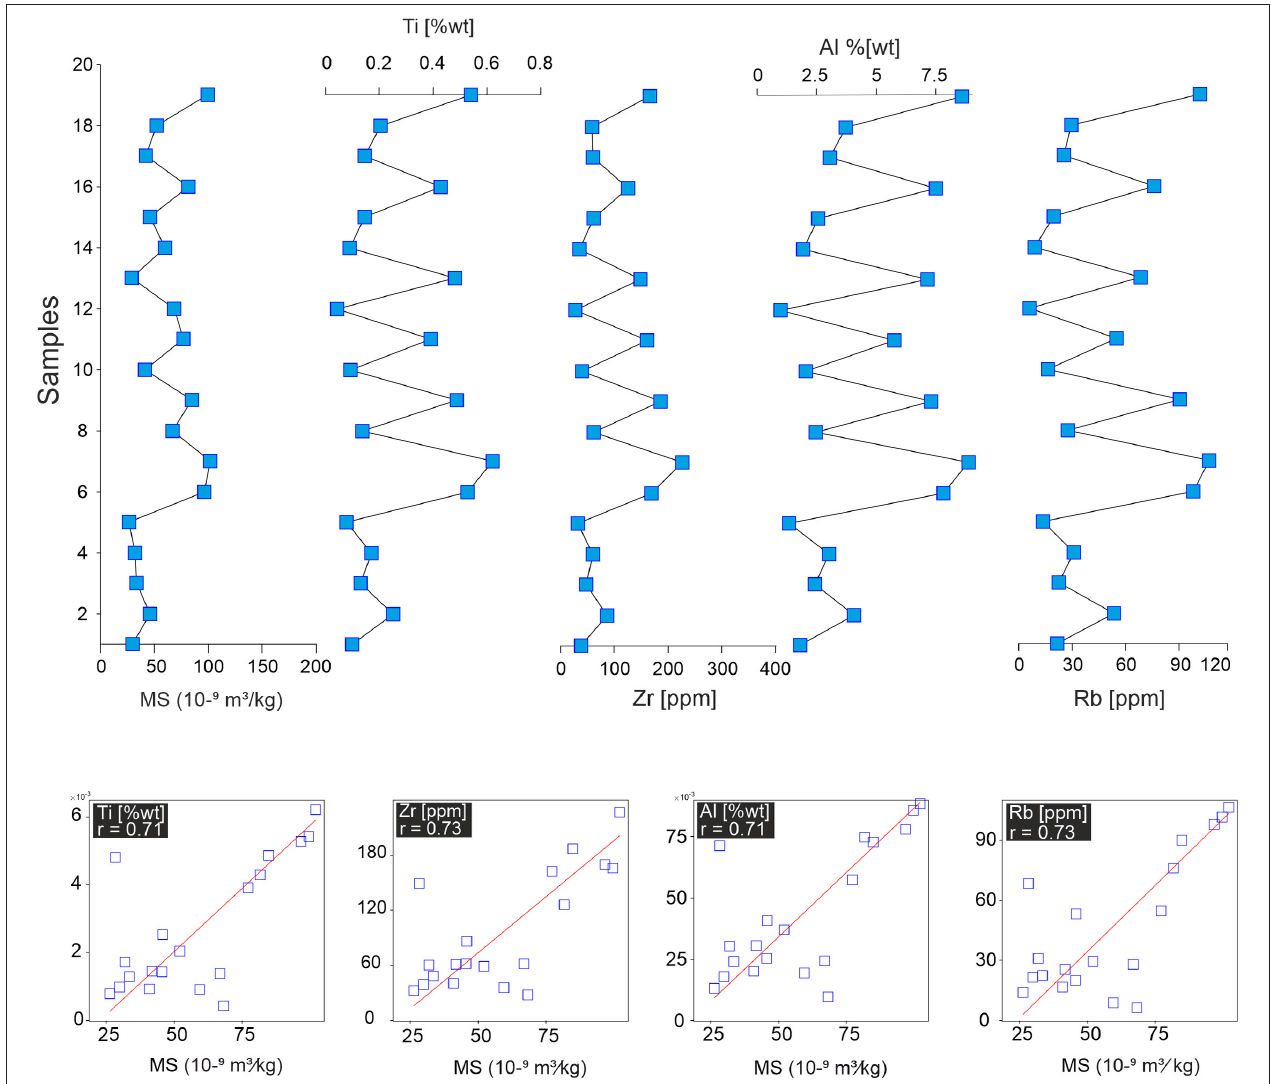
FIGURE 4 | Correlation between magnetic susceptibility (MS) and trace elements (Ti, Zr, Al, and Rb). These elements are proxies for siliciclastic input into the marine depositional environment. The correlation between elemental profiles and MS indicates a magnetic susceptibility signal driven by climatically controlled changes of inputs into the